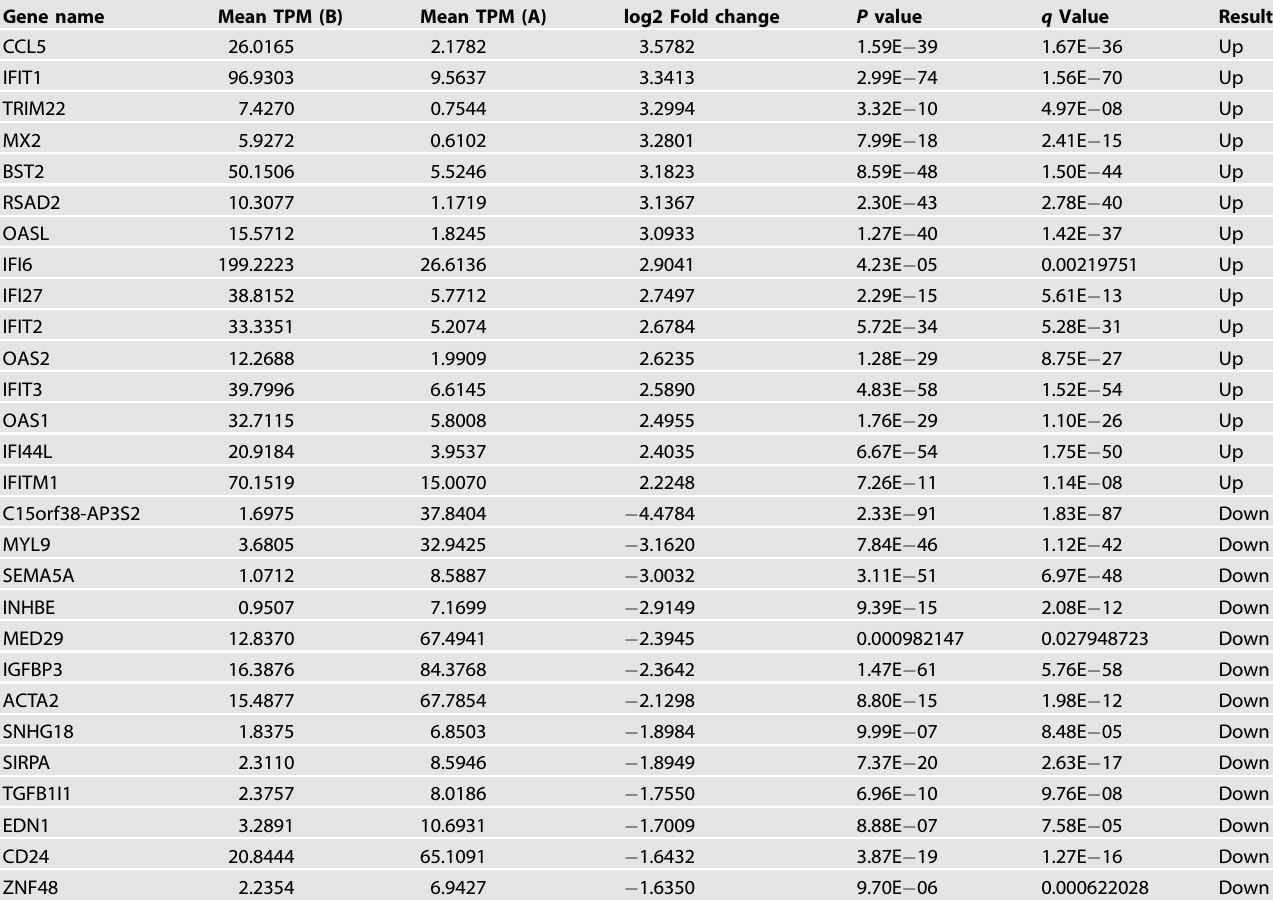
Table 6. Comparison group expression difference analysis